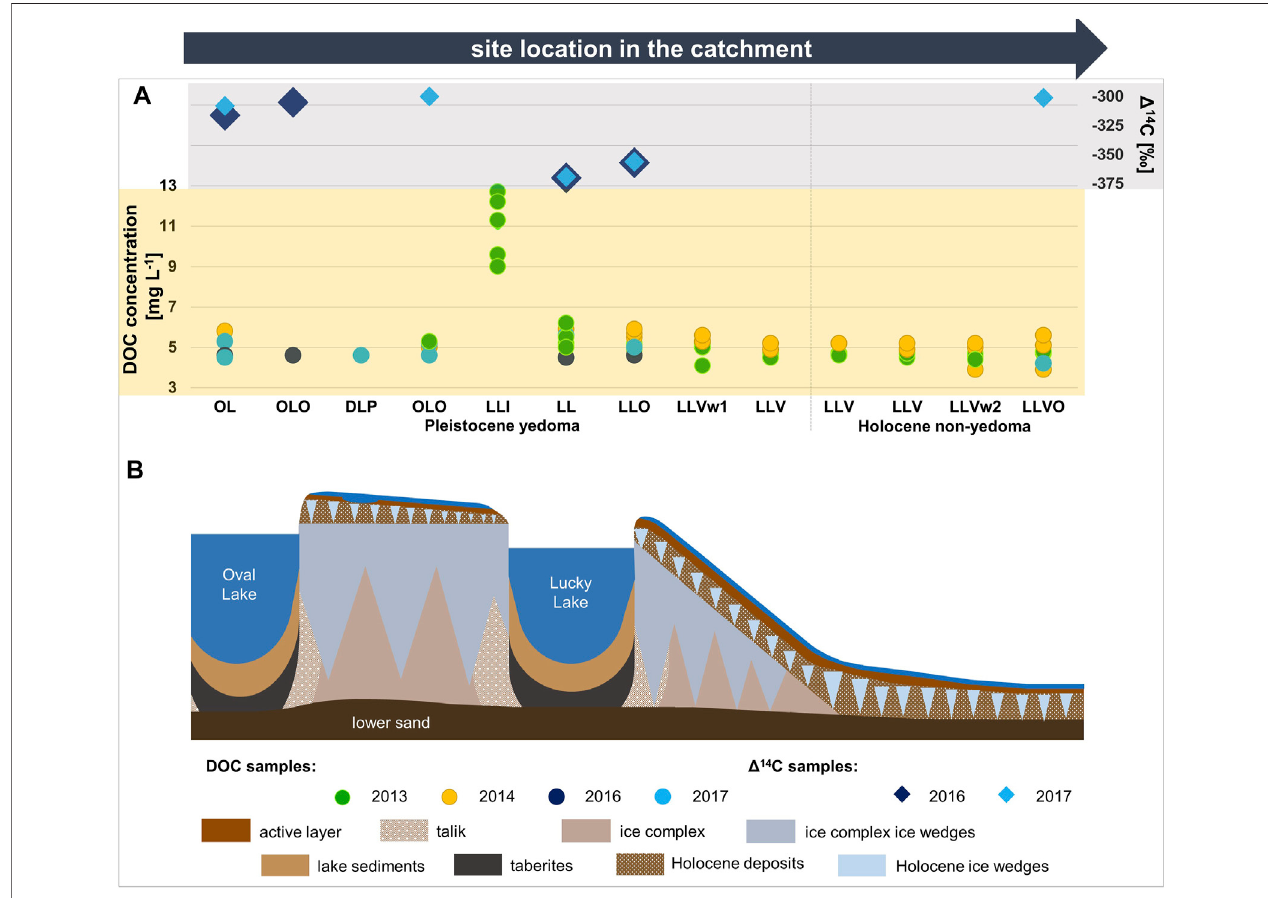
FIGURE4| LuckyLake fl owpathwith (A) DOCconcentrationsand Δ 14 CalongPleistoceneyedomaandHolocenenon-yedomawithin fl owsfromyedomauplands (LLI), thermokarstlake OvalLake (OL)and its out fl ow(OLO)drainingadrainedlake pond (DLP) and then draininginto theLucky Lake (LL), Lucky Lake out fl ow (LLO) and Lucky Lake stream (LLV) on Pleistocene yedoma with weir 1 (LLVw1), Lucky Lake stream on Holocene non-yedoma and weir 2 (LLVw2), and mouth of Lucky Lake stream (LLVO) to the Olenyokskaya Channel; and (B) schematic 2-dimensional cross section of the study site.